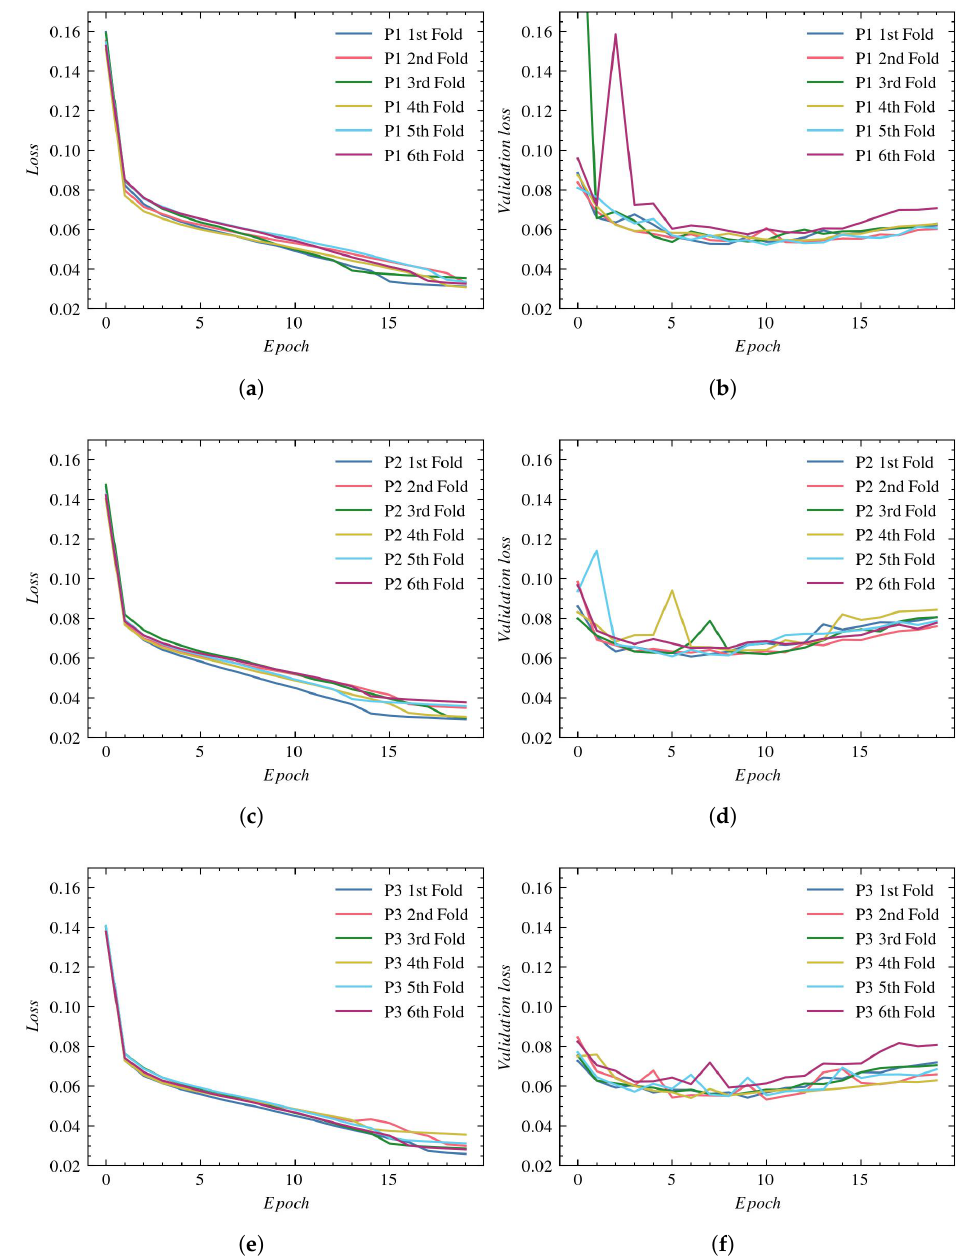
Figure 9. Loss plots for BCDU-Net architecture: ( a ) training using P1, ( b ) validation using P1, ( c ) training using P2, ( d ) validation using P2, ( e ) training using P3, and ( f ) validation using